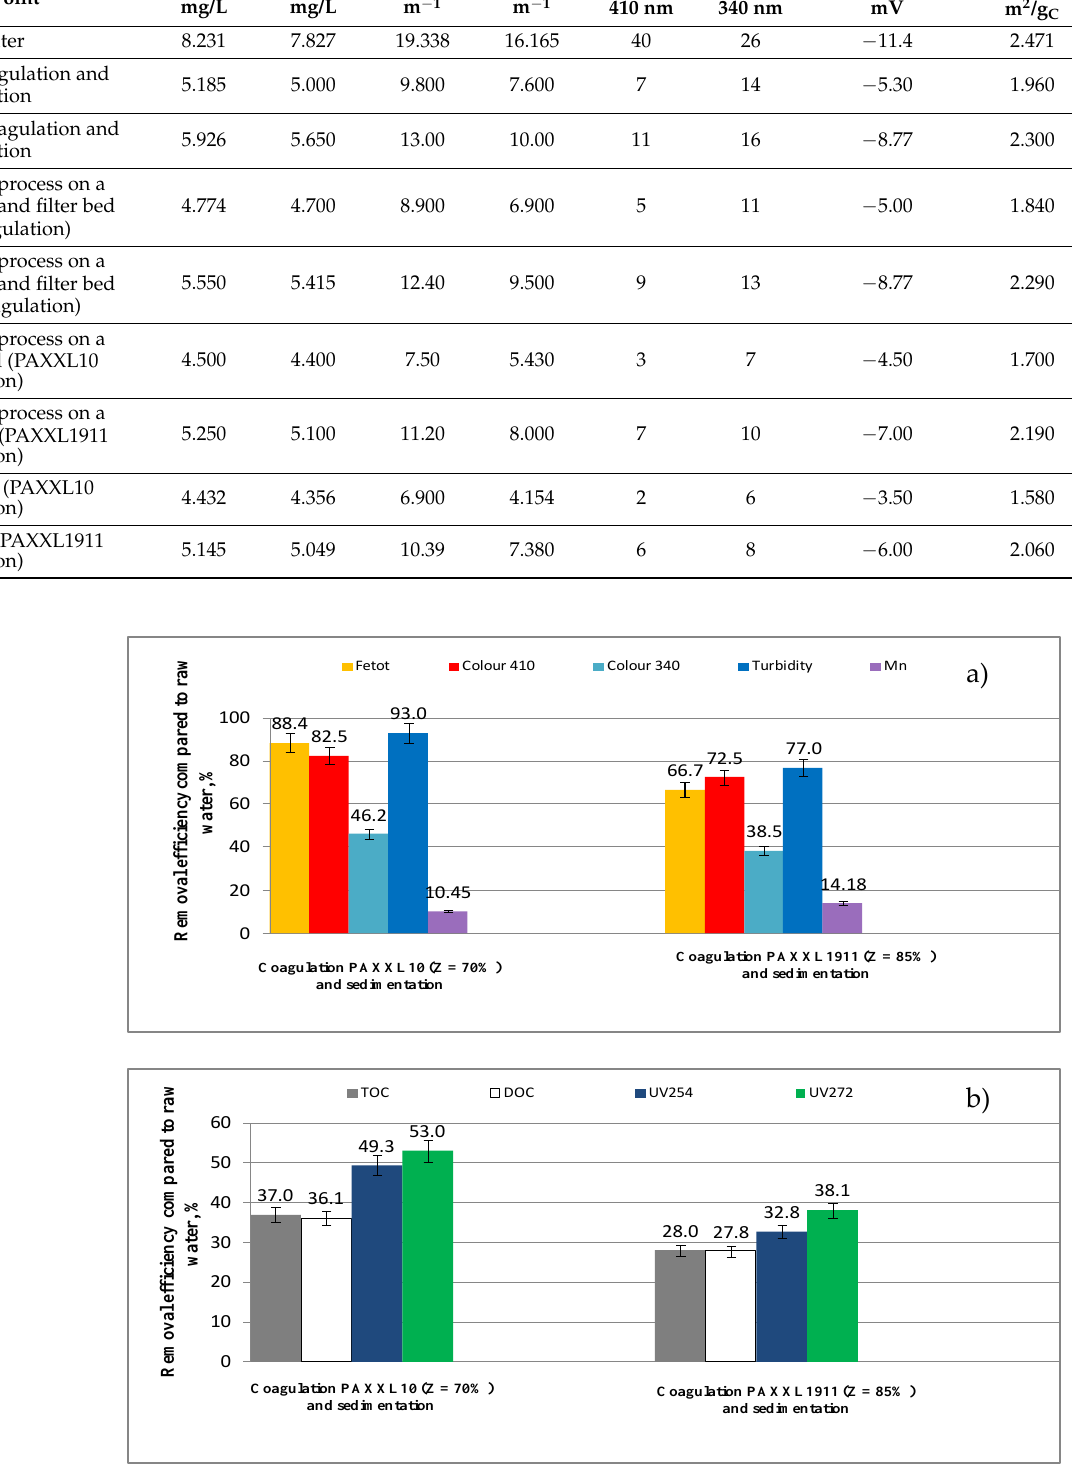
Figure 3. Efficiency of iron total, colour at wavelength 410 nm and 340 nm, turbidity, manganese ( a ) and TOC, DOC, UV 254 , UV 272 ( b ) removal from water by coagulation.